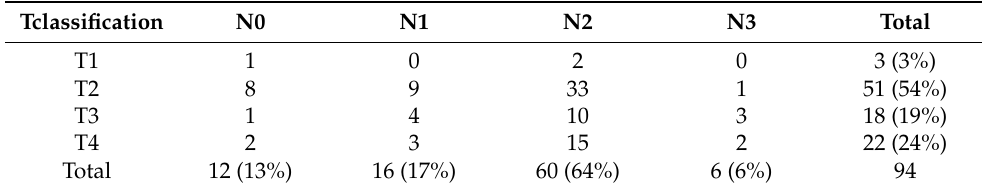
Table 2. Distribution of 94 patients according to TNM